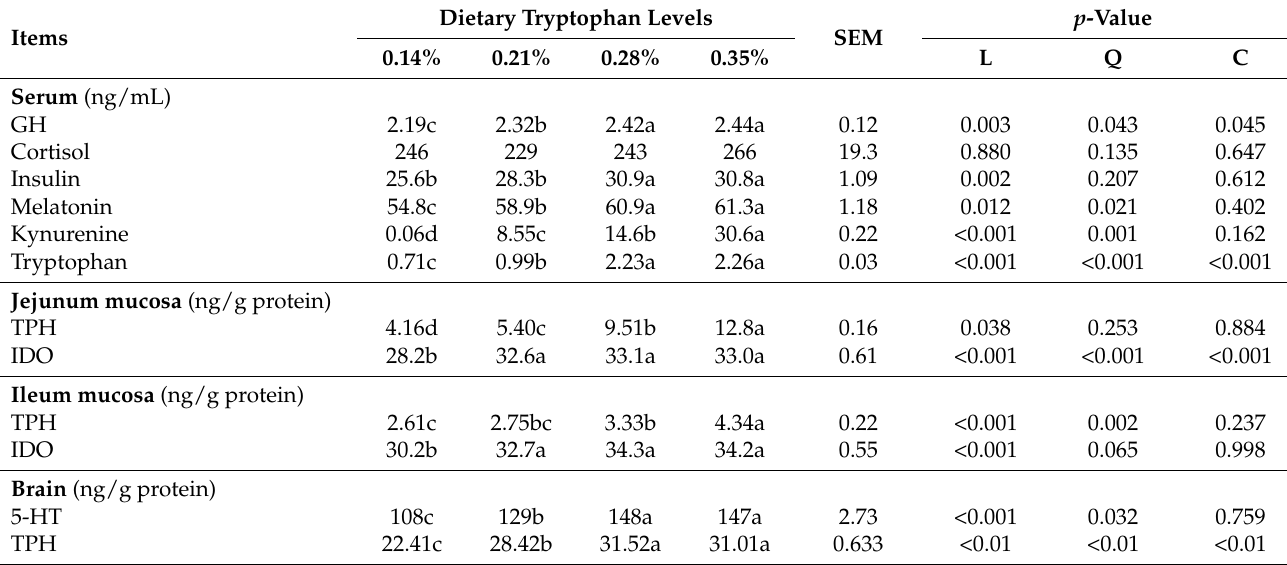
Table 5. Effects of dietary tryptophan levels on the concentrations of hormones and tryptophan metabolic products in the serum and the enzyme activities of TPH and IDO in the jejunal and ileal mucosa of weaned piglets.